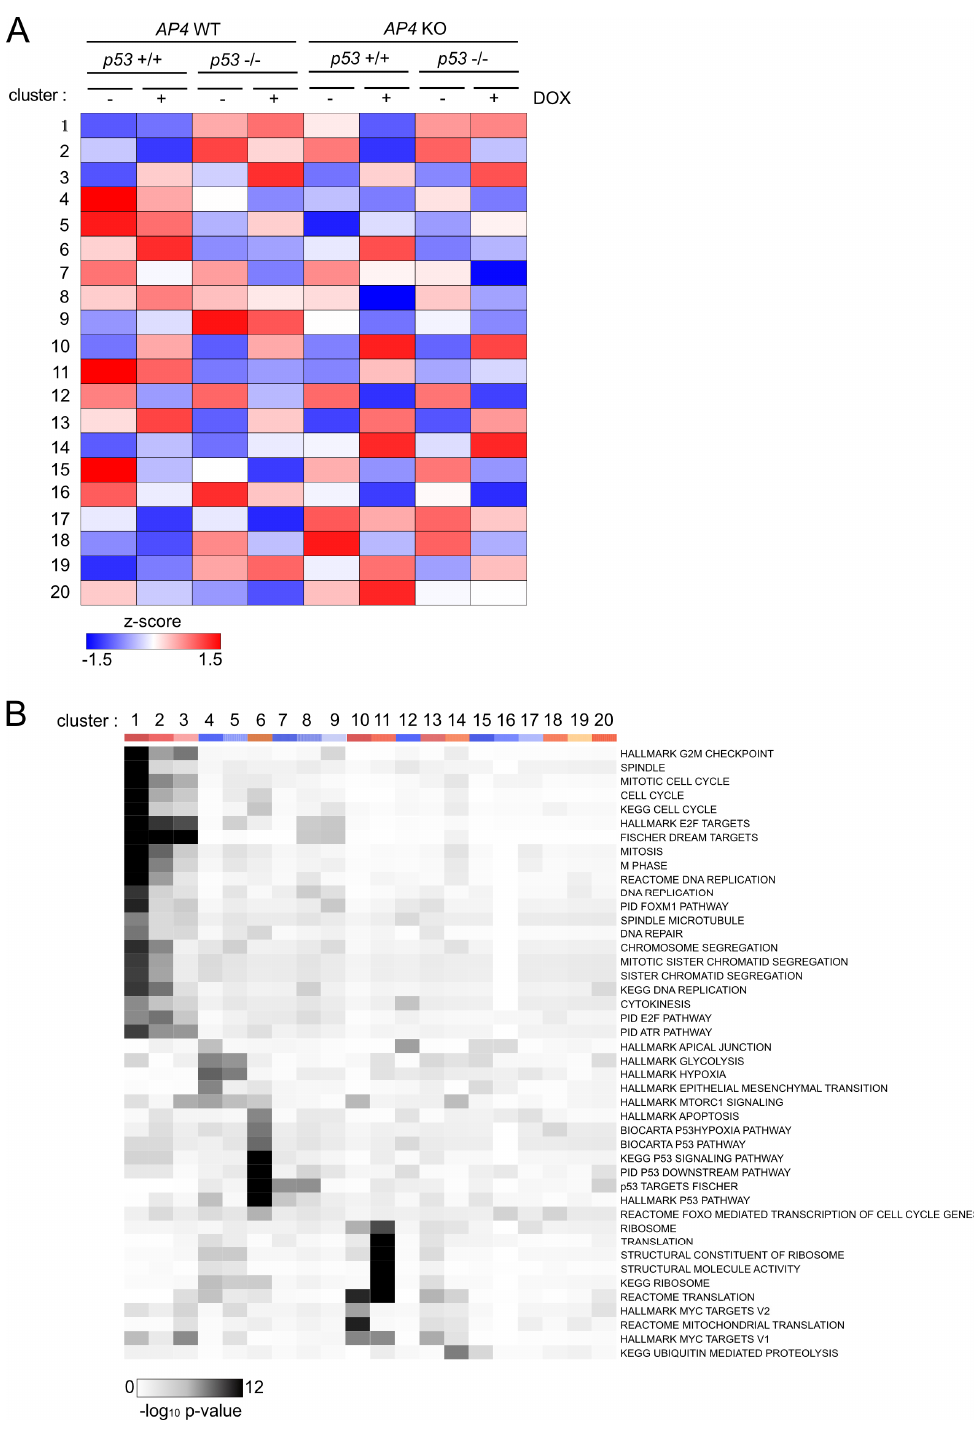
Figure 7. Clustering of gene expressions with genotype-dependent differences in c-MYC-mediated regulation. ( A ) Heat-map of RNA expression clusters comprising genes with statistically significant, genotype-dependent differences in regulation after induction of c-MYC. Clusters were determined using KMeans clustering. Cluster numbers are indicated on the left. ( B ) Heat-map of enrichment of functional categories in the transcriptional clusters as determined in ( A ). Cluster numbers are indicated on top. Statistical significance was determined by Fisher´s exact test.